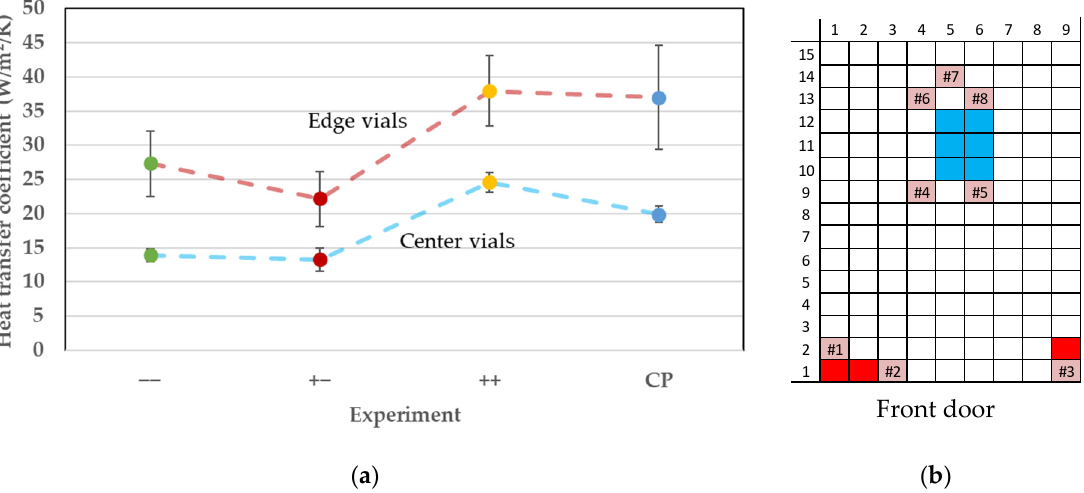
Figure 8. ( a ) Vial heat transfer coefficients for edge and center vials for various process conditions. ( b ) Vial position and category (red: edge vials, blue: center vials).